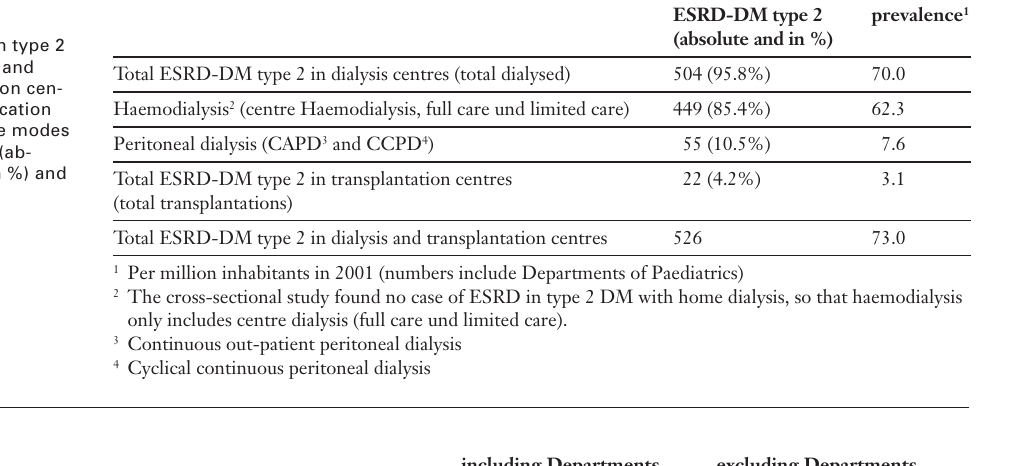
Percentage of ESRD in type 2 DM in ESRD patients.